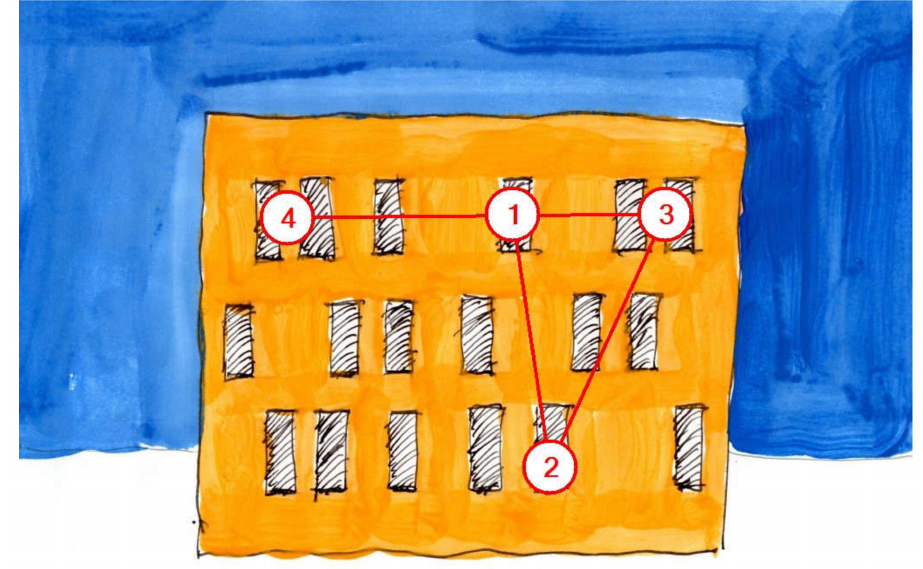
Figure 5. Scanning sequence for contemporary building with vertical windows aligned horizontally.